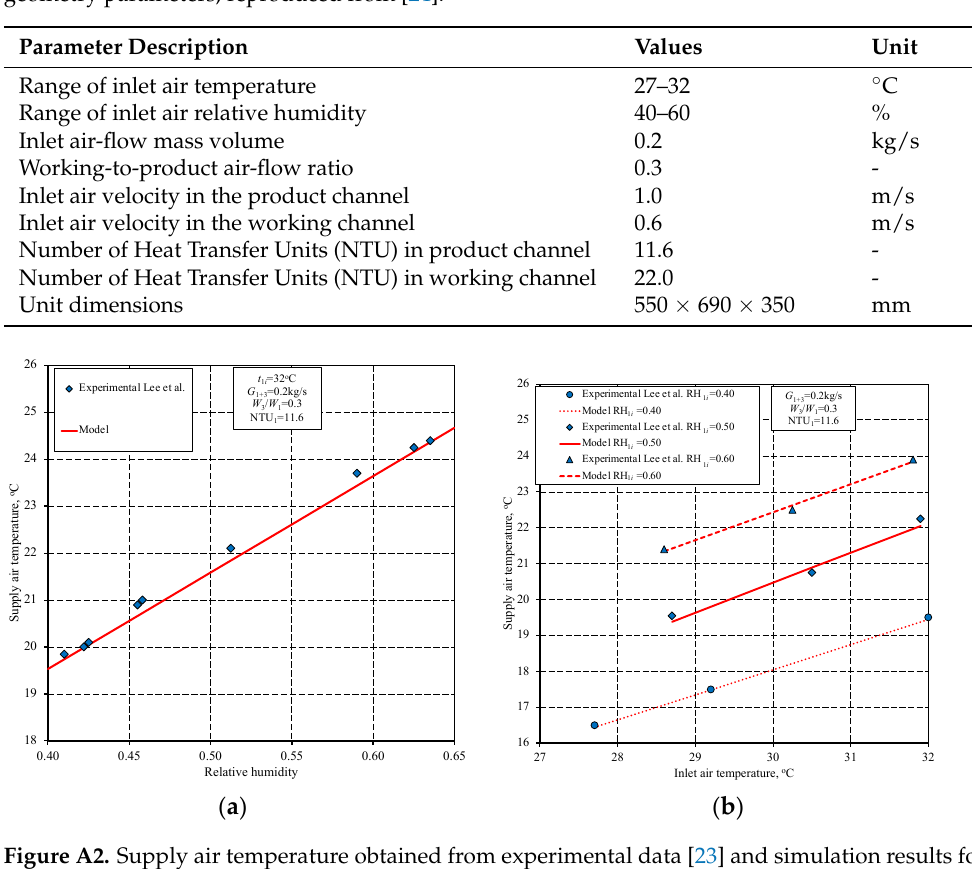
Table A1. The regenerative counter-flow heat and mass exchanger characteristic operating and geometry parameters; reproduced from [24].